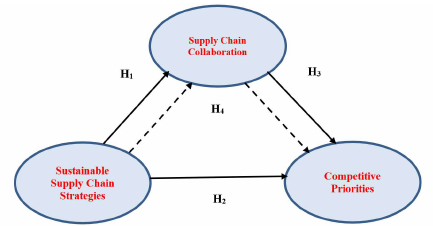
Fig. 1. The proposed Model of the